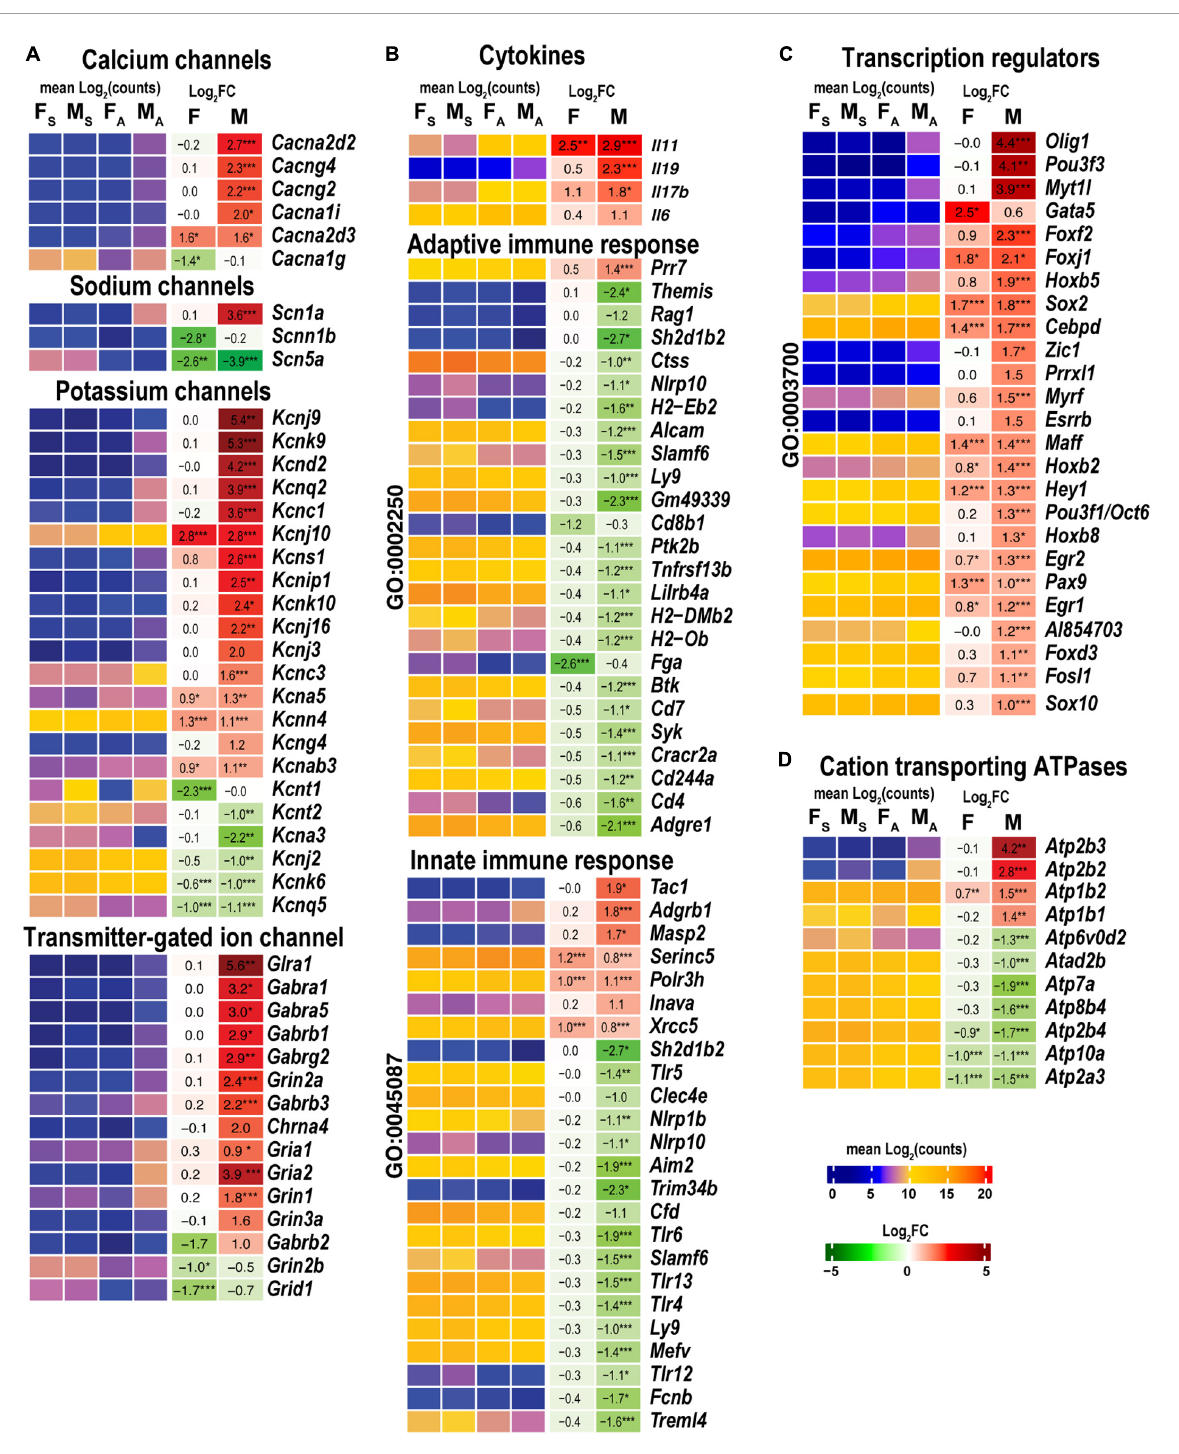
FIGURE8 Males exhibited stronger activation of ion channels, transcriptional regulators, cation transporting ATPases, and select cytokines. Innate and adaptive immunity exhibited a male-specific decrease. (A) Ion channel genes. (B) Cytokines, adaptive (Go term GO:0002250), and innate (GO term GO:0045087) immunity-related DEGs. (C) DNA-binding transcriptional regulators (GO term GO:0003700). (D) Cation transporting ATPases. Heatmaps display normalized mean log 2 (counts) in sample groups (F S , female sham; M S , male sham; F A , female axotomy; M A , male axotomy) and log 2 FC in female (F) and male (M); ( n = 6 mice/group, 2 mice/sample (pooled), 3 sample/group) of respective DEGs. Heatmap colors correspond to the respective scales. Log 2 FC significance was determined in DESeq2 using Wald test: *, p ≤ 0.05; **, p ≤ 0.005; ***, p ≤ 0.0005. DEGs were sorted by log 2